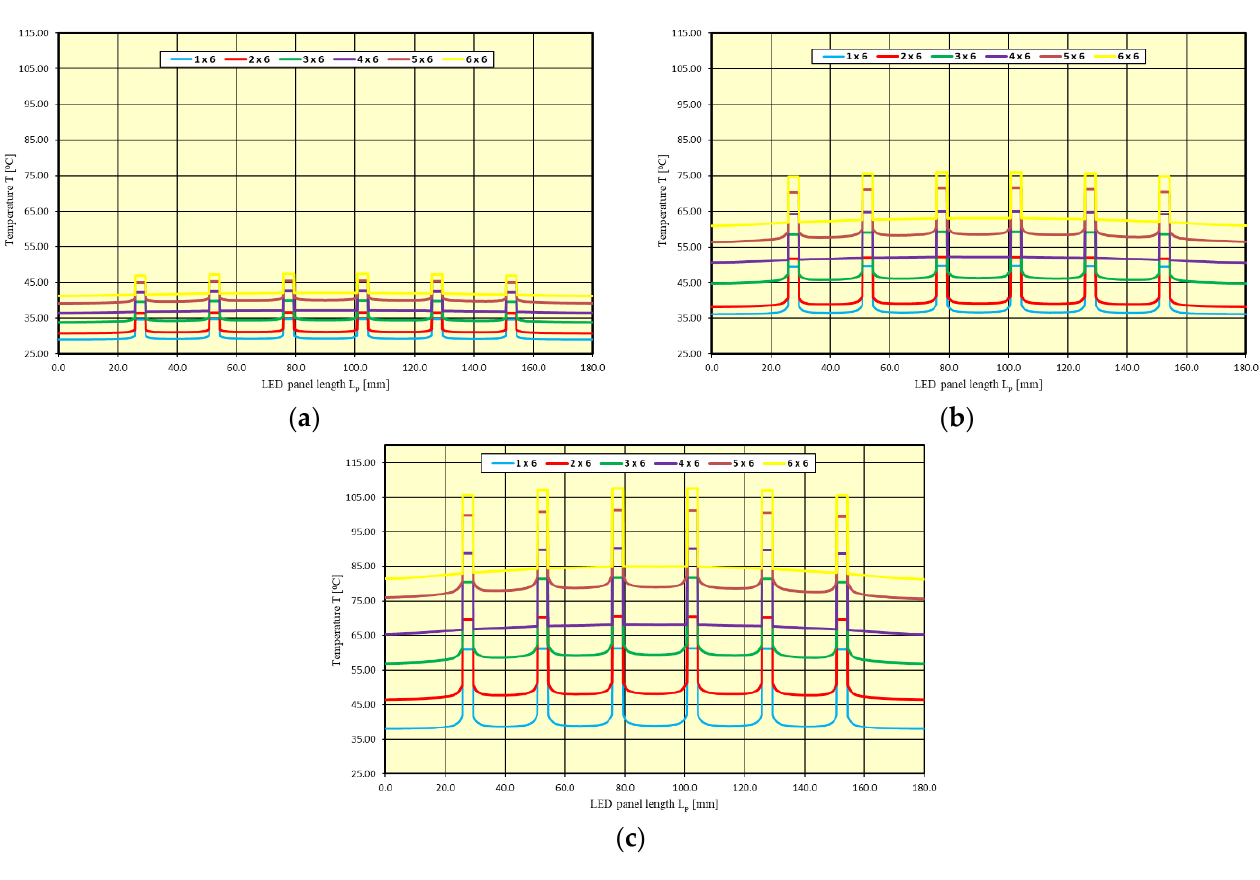
Figure 10. Temperature distribution for selected panels and three values of I F current along the axis with the maximum temperature T j of LEDs: ( a ) 1 × 6, ( b ) 3 × 6, ( c ) 5 × 6, ( d ) 6 × 6.